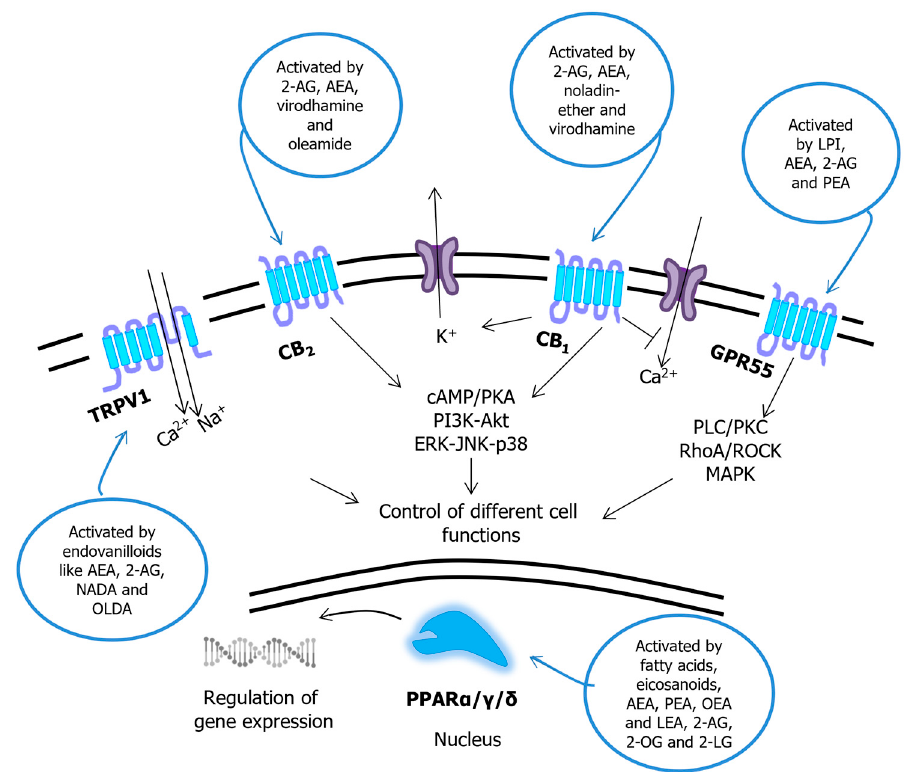
Figure 4. Signal transduction pathways triggered by endocannabinoids and congeners. Abbrevia- tions: AEA— N -arachidonoylethanolamine (anandamide); 2-AG—2-arachidonoylglycerol; 2-LG—2-